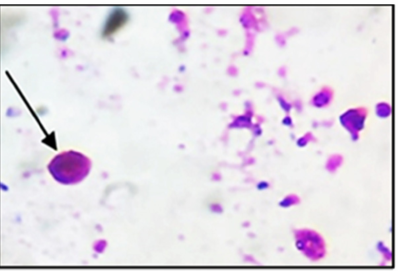
Figure 2. Cryptosporidium oocysts in the stool Modified Ziehl–Neelsen stain (MZN stain X1000). The black arrow referred to Cryptosporidium oocysts. Table 1. The number of Cryptosporidium shed oocysts in different experimental groups. Experimental